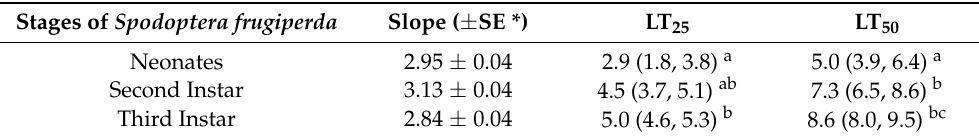
Table 4. Lethal time-response mortality (LT) of the fall armyworm ( Spodoptera frugiperda ) develop- mental stages treated with rabbit Table 3. Lethal dose (LD), regression slope and fiducial limits (FL) of the rabbit urine needed to reduce the damage of the fall armyworm ( Spodoptera frugiperda ) larval stages feeding on maize treated by 25 and 50%.